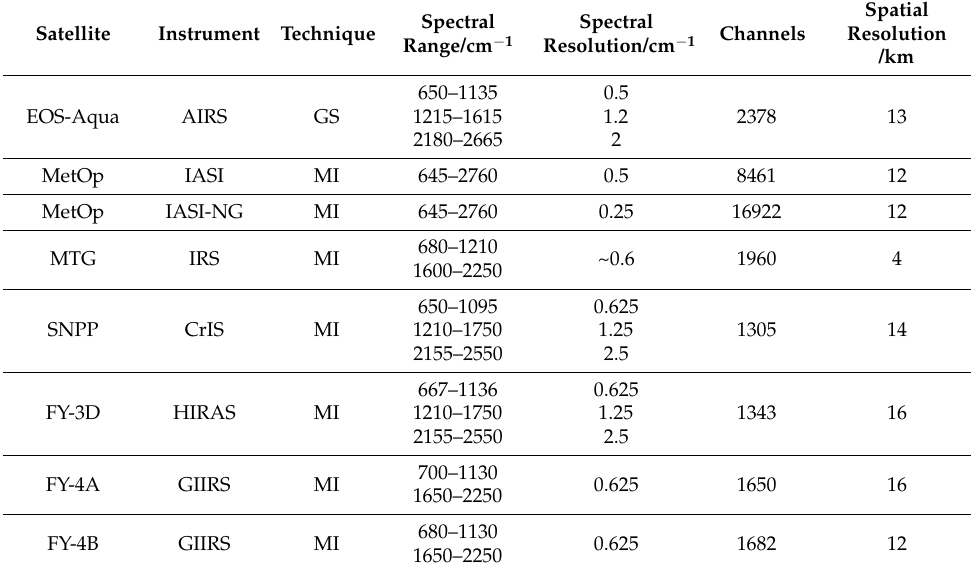
Table 1. The basic parameters of satellite-borne hyperspectral infrared atmosphere vertical sounder.